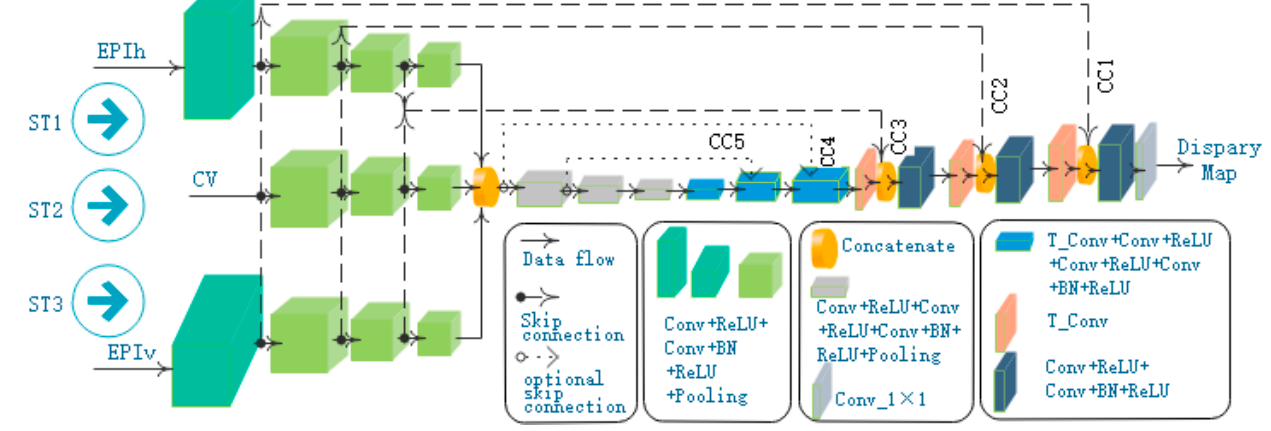
Figure 4. The architecture of ESTNet.